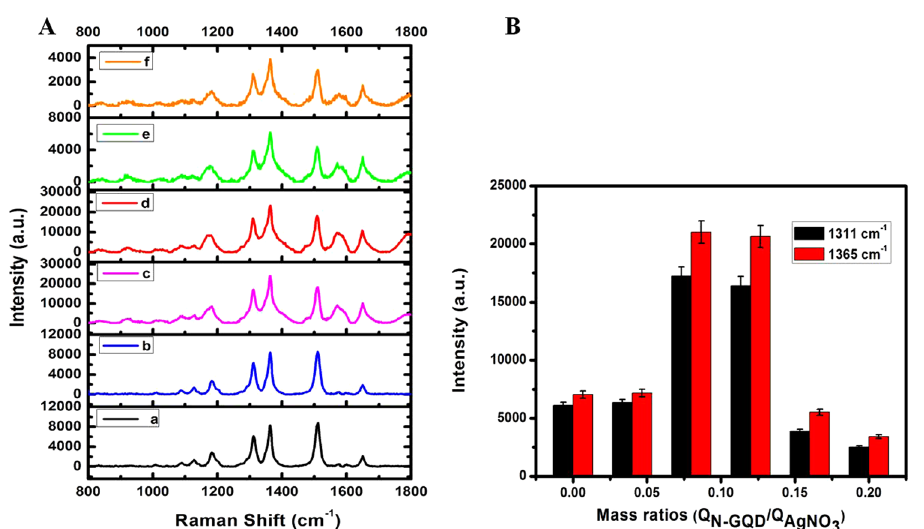
Figure 4. SERS spectra of R6G (1 μ M) adsorbed on freshly prepared Ag NPs (curve a) and Ag NP@N-GQD (curves b–f) with various mass ratios (Q N-GQD /Q AgNO3 = 0, 0.04, 0.08, 0.12, 0.16 and 0.20, respectively, from a to f) excited by laser at 785 nm. ( B ) The histograms were generated from the Raman intensity valuesat 1311 and 1365 cm − 1 . The magnitude of the error bar is equal to the standard deviation for each mass